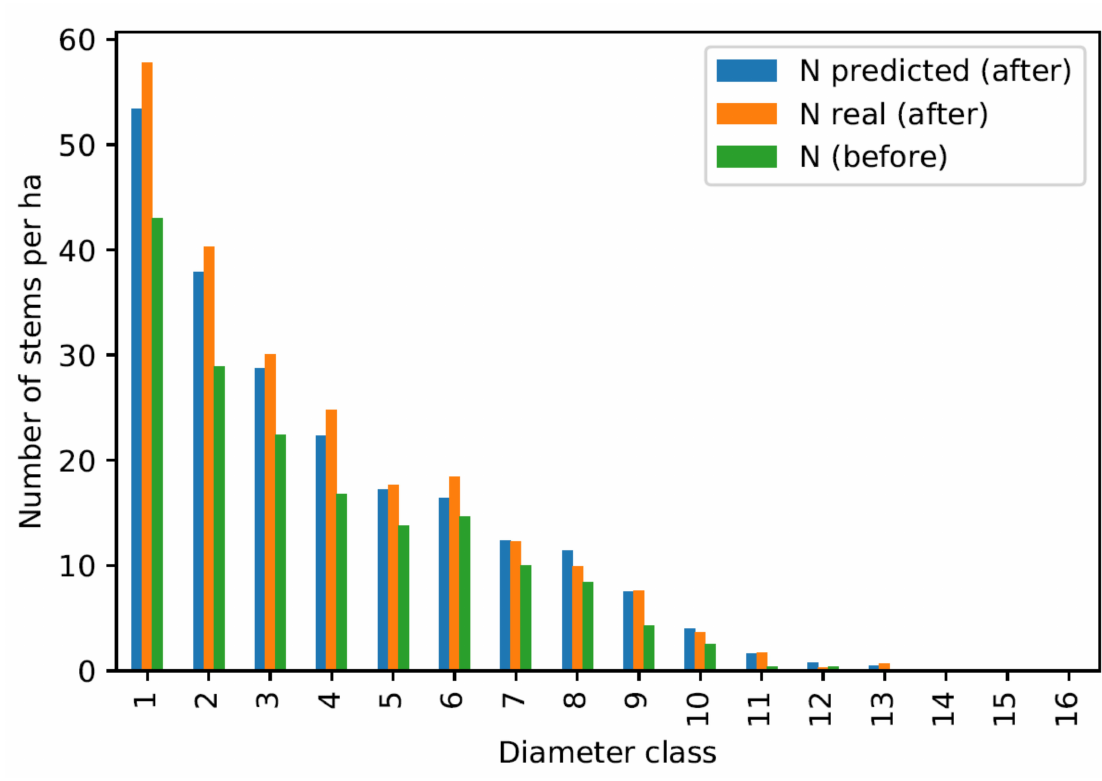
Figure 8. Overall prediction quality control for the division 1974 inventoried in the year 2003.